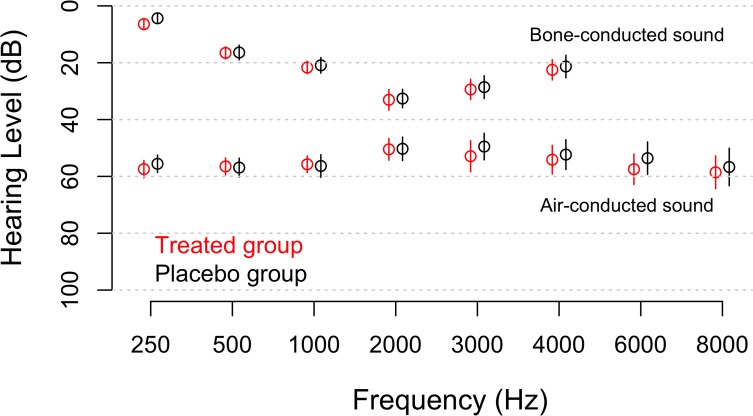
Hearing thresholds of the placebo group and the N-Acetyl cysteine group (“Treated group”) at baseline.Thresholds for air-conducted sound (lower set of points) are measured by standard headphones covering the ears; thresholds for bone-conducted sound (top data set) are determined by placing a vibrator on the mastoid process. Bone-conducted sound was not measured at frequencies higher than 4000 Hz as this is not part of normal clinical routine. Rings represent the mean values; vertical lines are 95% confidence intervals for the mean. Hearing was measured at the same set of frequencies in all patients, but a horizontal offset was added when plotting to improve the clarity of presentation.